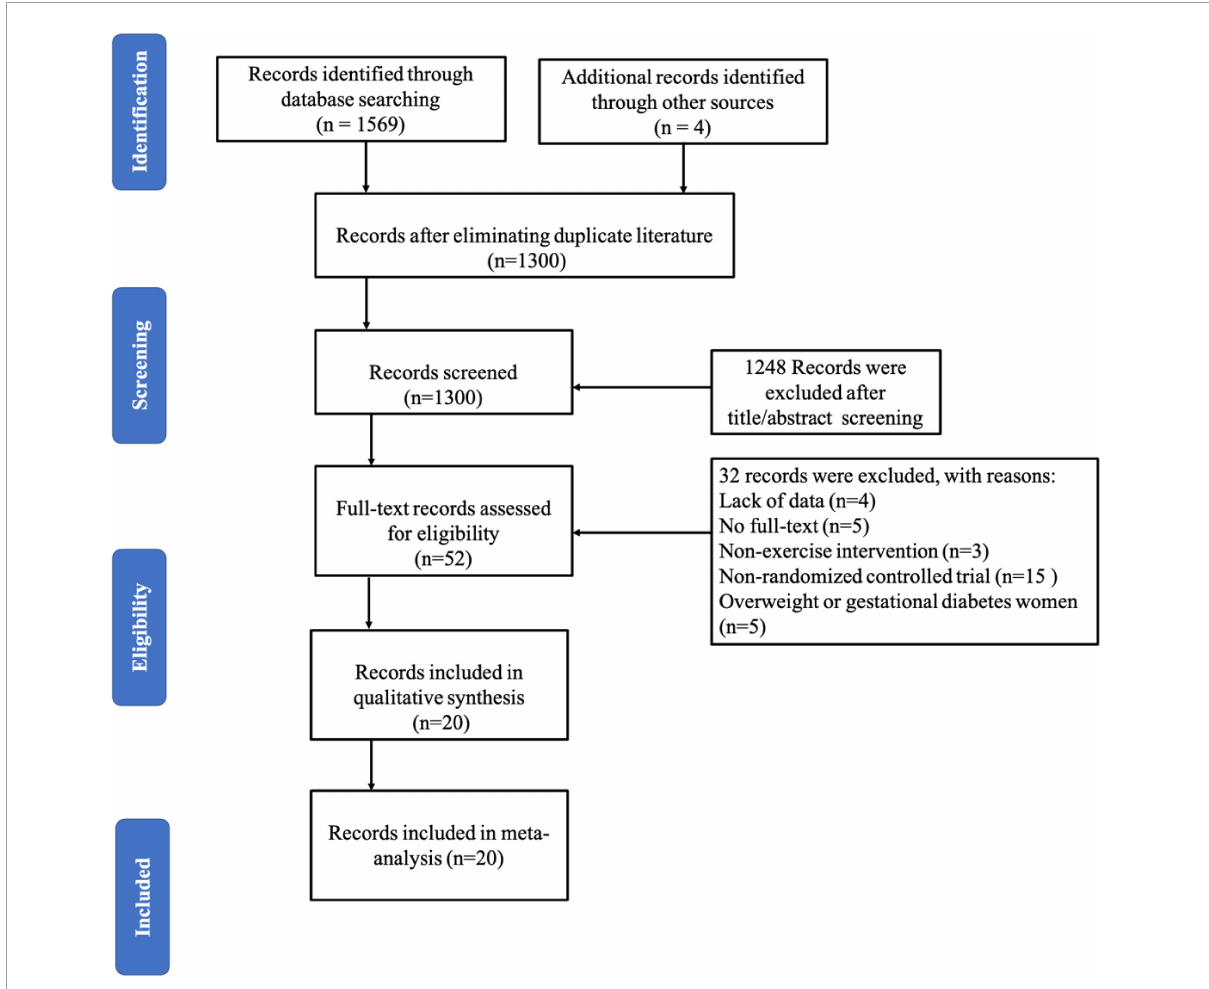
FIGURE1 Flow diagram for the search